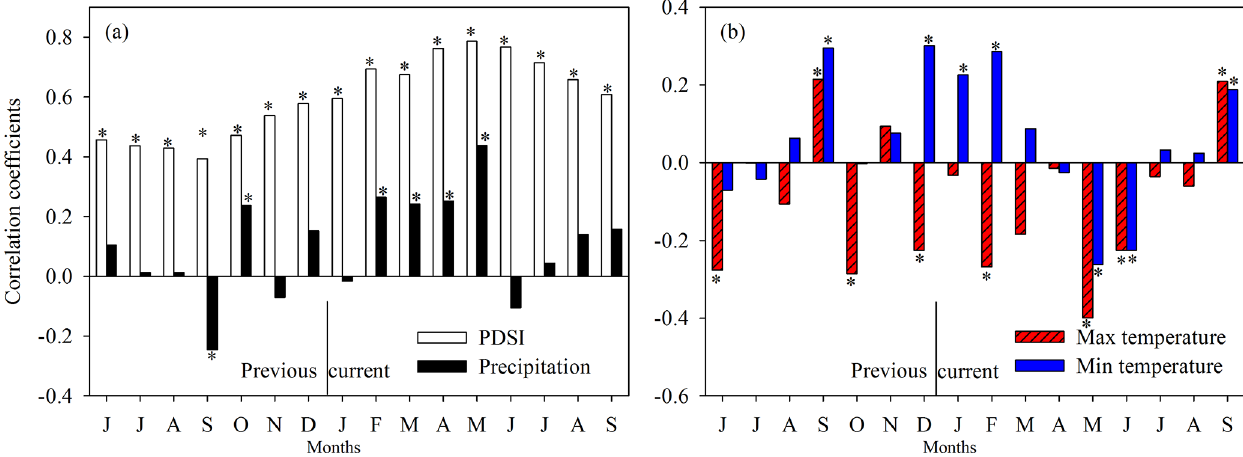
Figure 4. Pearson correlation coefficients between the tree-ring index of C. deodara and the monthly total precipitation (1965–2013), scPDSI (1960–2013) (a) , monthly maximum, and minimum temperature (1965–2013) (b) from June of the previous year to September of the current year. Significant correlations ( p< 0 . 05) are denoted by asterisks. “Previous” and “current” represent the previous and current year,